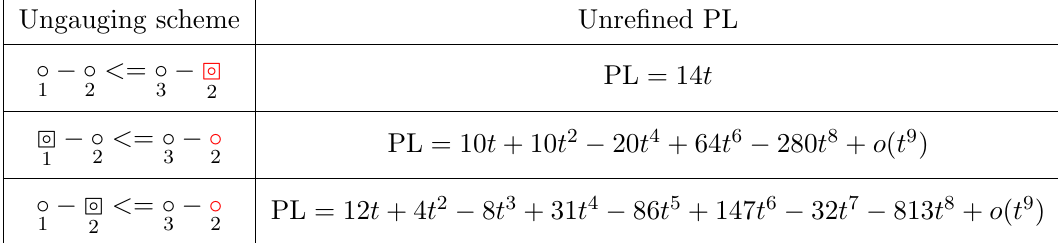
t in terms Sp(3)